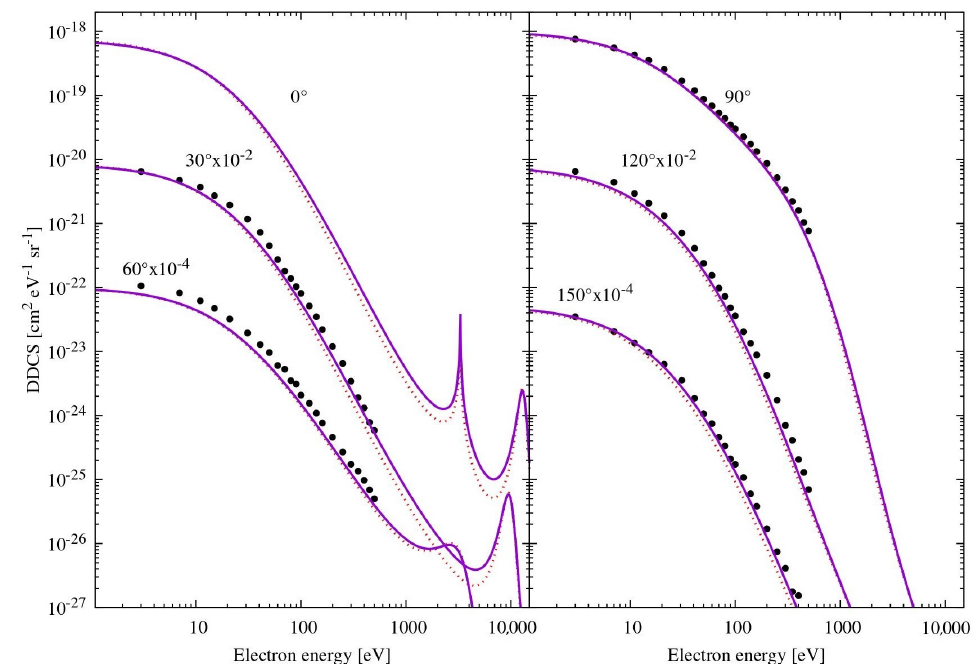
Figure 3. Double differential cross-section for single ionization of He atoms by 6 MeV/u C 6 + impact as a function of the electron energy for a fixed emission angle. Theory: dotted-line, post CDW; full-line, complete hybrid post CDW; experiments, circles [25].